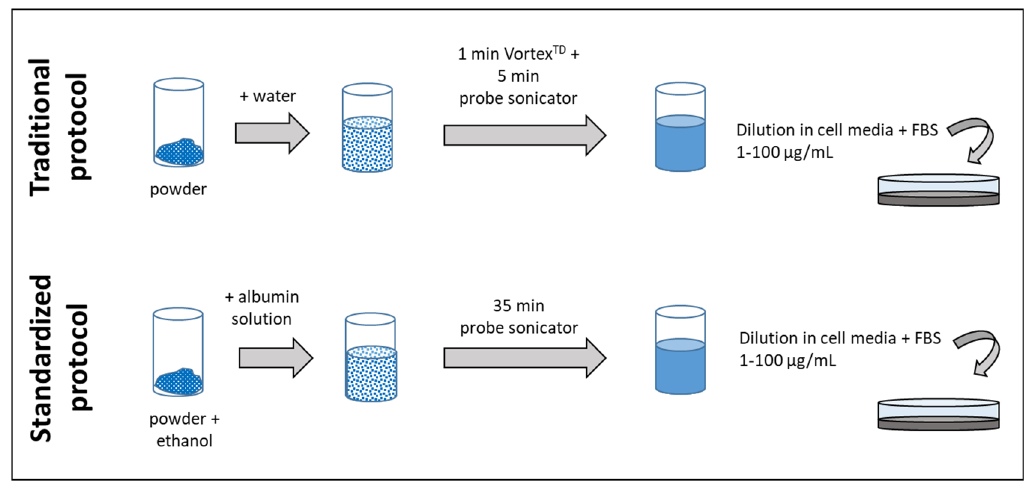
Figure 1. Main di ff erences between the two protocols used to prepare the NM suspensions for Figure 1. Main differences between the two protocols used to prepare the NM suspensions for in vitro in vitro tests.